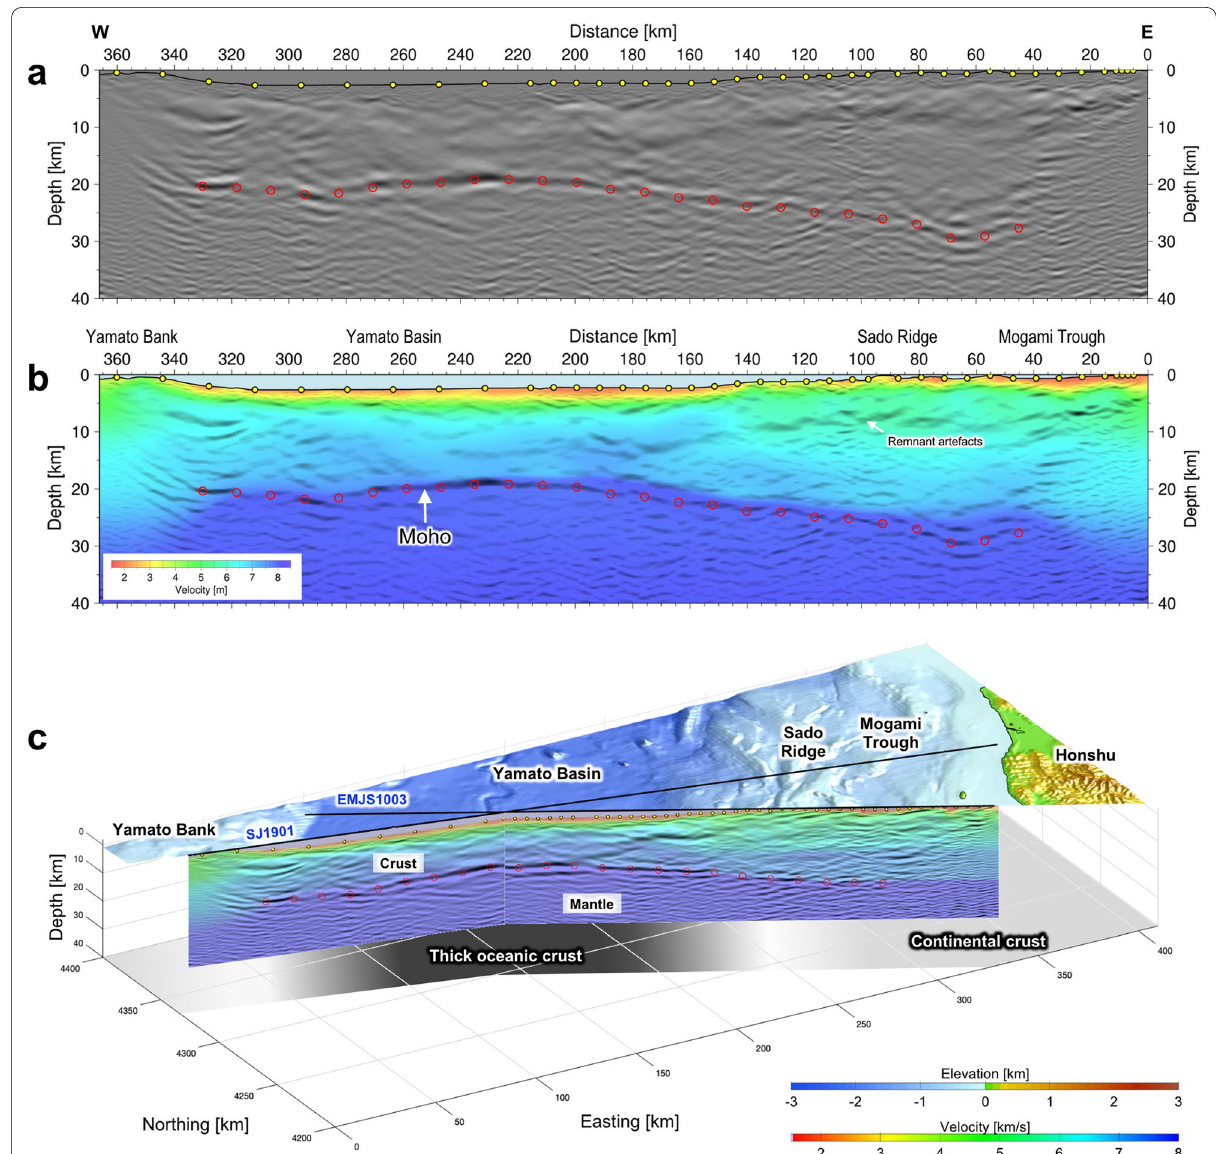
Fig. 4 Seismic profiles along line SJ1901: a reflection profile obtained by RTM from airgun-OBS data in this study and b velocity model obtained by traveltime tomography (after No et al. 2020). c 3D view of compiled seismic profiles of RTM images overlaid by tomography velocities along the two crossed lines with bathymetry. The crust varies from the thick oceanic crust beneath the Yamato Basin to the continental crust beneath Honshu Island, which was classified by Sato et al. (2014, 2020). The yellow dots indicate OBS locations, and the red circles denote the probable Moho